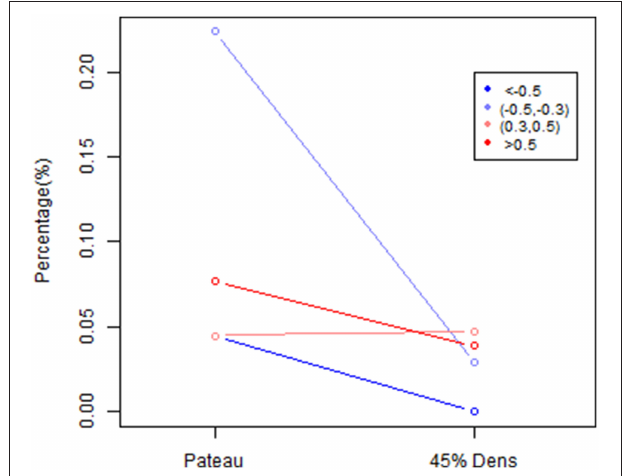
FIGURE 13 | The percentage difference based on size effect between λ * platu - and λ * 0.45 -based partial correlation matrix. Edges are classified into 4 categories based on size effect: significant positive : > 0.5, significant negative: < 0.5, moderate positive: (0.3,0.5) and moderate negative ( − 0 −